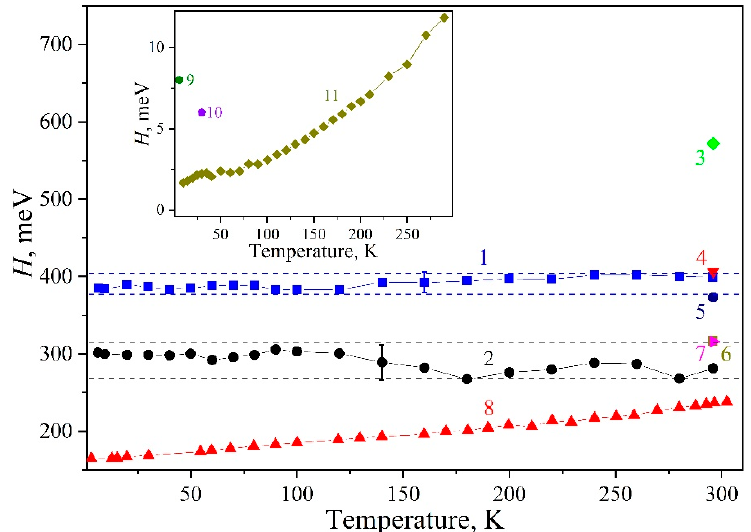
Figure 2. The values of H for various InP modifications: 1: H vis ( T ) [22], 2: H G (T) [22], 3: InP / ZnS [6], 4: InP / ZnS [10], 5: 3.2 nm InP / ZnS [5], 6: 2.3 nm InP / ZnS [26], 7: InP / ZnS [4], 8: PL H ( T ) InP / ZnS [27]. Inset: 9: InP single crystal [28], 10: InP nanowires [29], and 11: InP single crystal [30].